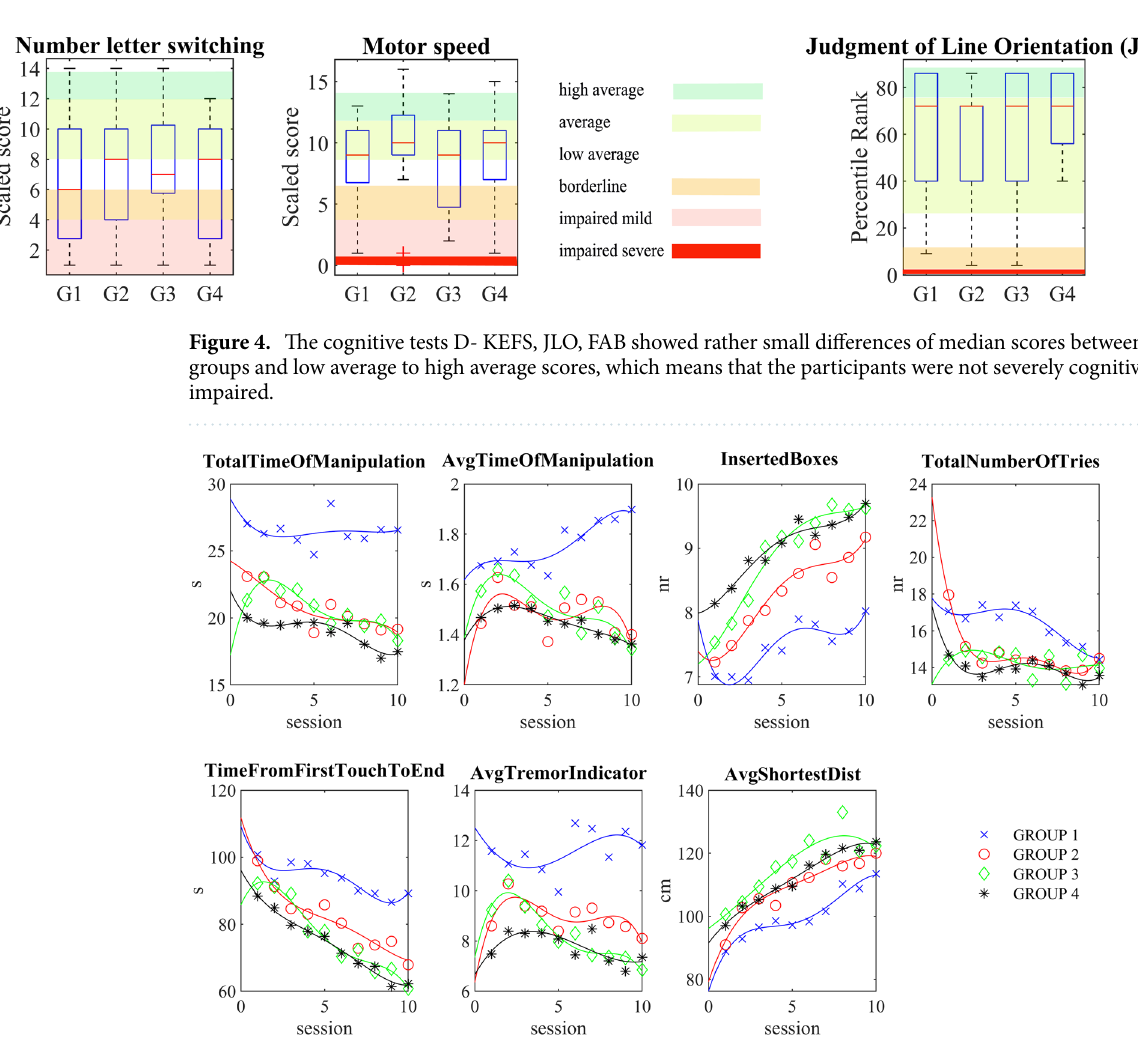
Figure 5. Kinematic and exergame parameters showed that group 1 (the most difficult task with small bouncing cubes) needed more time to finish the task and had less success (lower number of inserted boxes). In contrast, members of Group 4 learned to use the larger cubes more quickly and completed the exergames with all 10 cubes inserted after 10